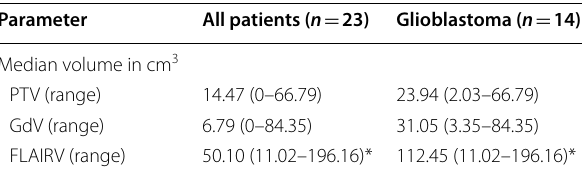
Table 1 4DST PET and MRI parameters in patients with newly diagnosed gliomas